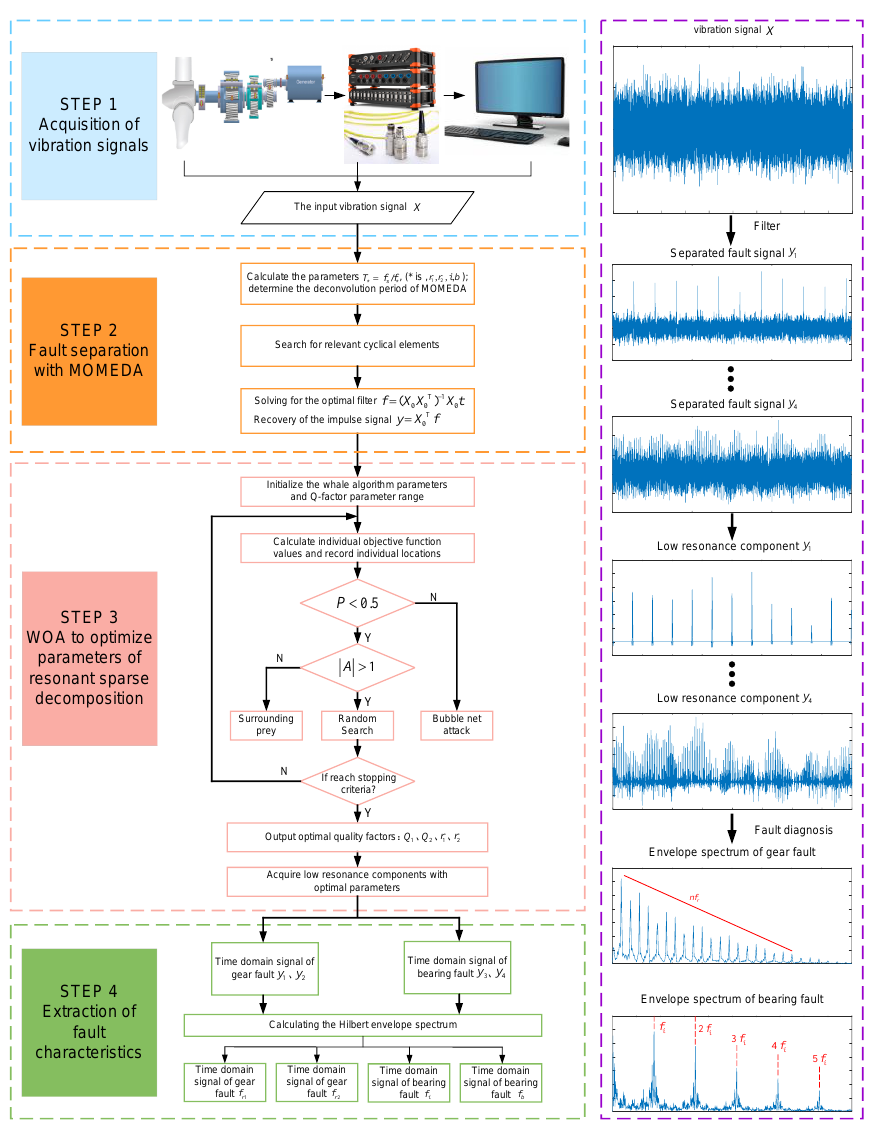
Figure 2. The flow chart of the proposed